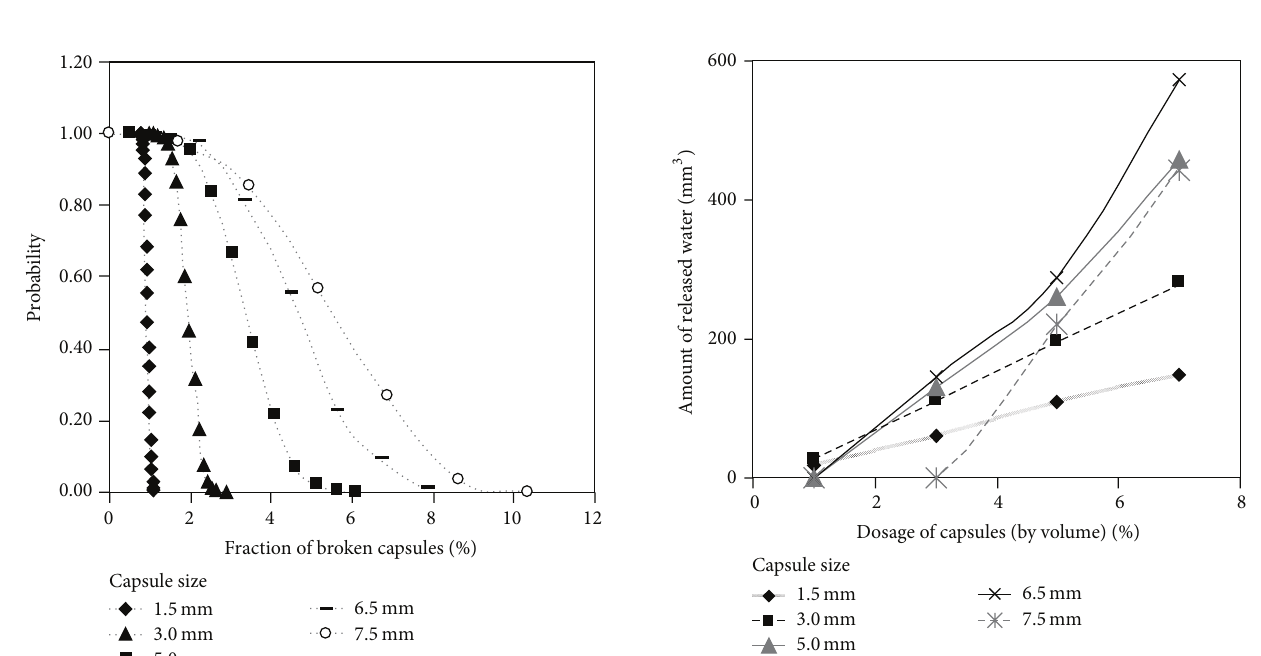
Figure 7: Probability of a crack hitting capsules with different size (the dosage of capsules is 5%).